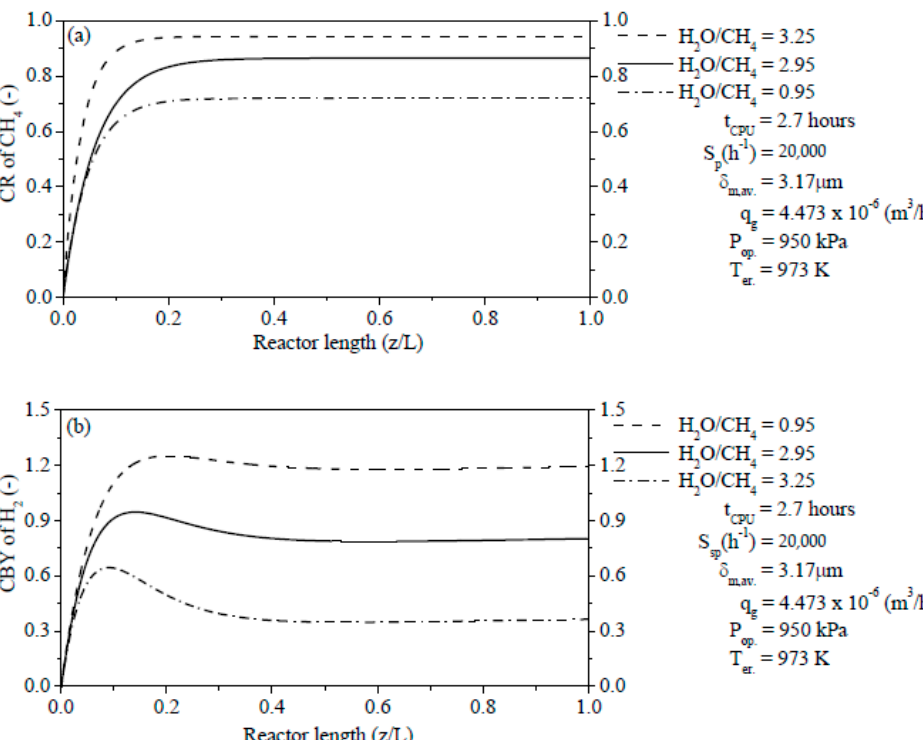
Figure 9. ( a ) Effect of the H 2 O/CH 4 ratio on the CR of CH 4 along of the reaction zone length from PBMR; ( b ) Effect of the H 2 O/CH 4 ratio on the CBY of H 2 along of the reaction zone length from PBMR.